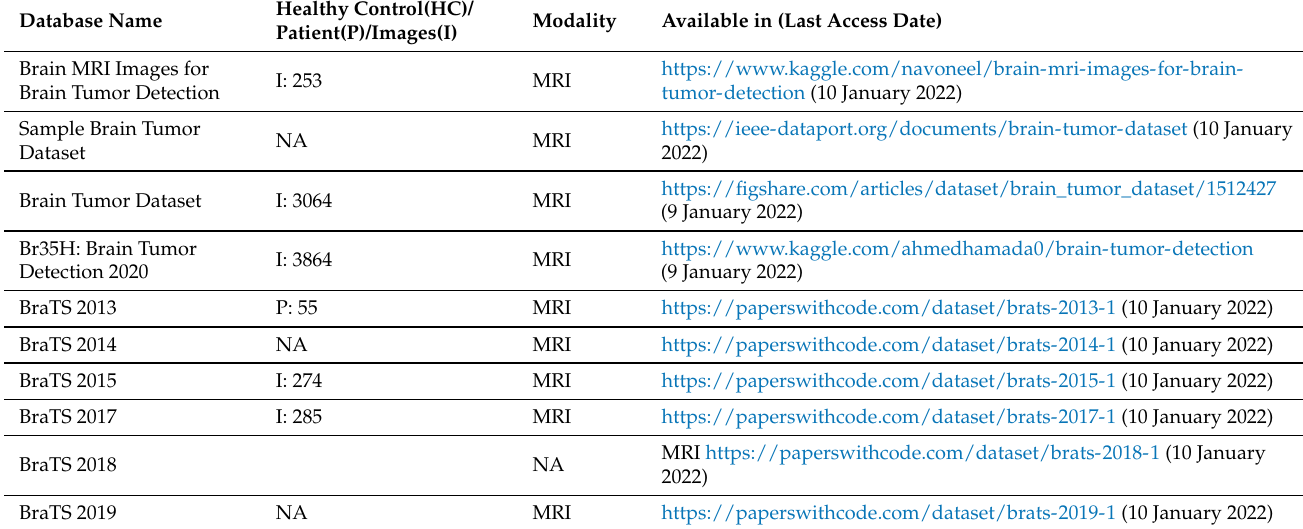
Table 5. A tabulation of popular datasets of brain